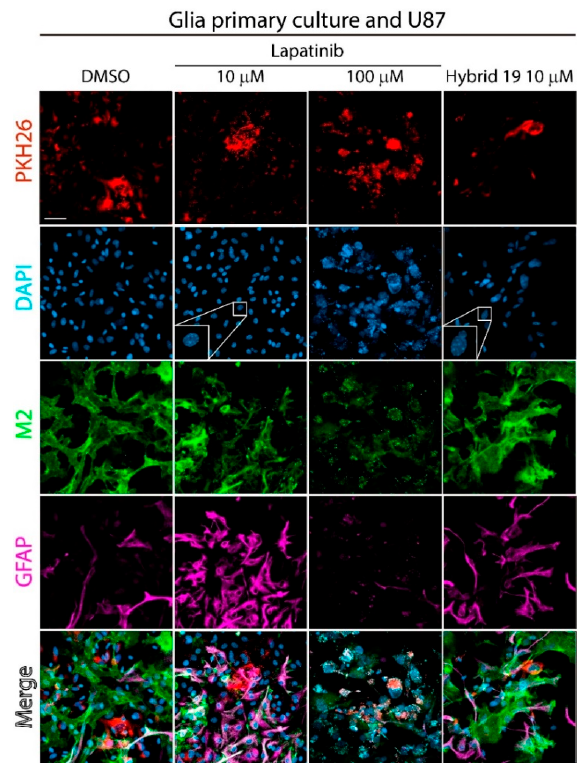
Figure 2. Effect of hybrid 19 or Lap on co-cultures of mixed glial cells with tumoral cells. Confocal images showing the co-culture of U87 MG cells (PKH26, red) with mouse neonatal cortical-derived astrocytes (M2, green and GFAP, magenta). The nuclei were stained with DAPI. Co-cultured cells were treated at IC 50,U87 MG doses of hybrid 19 or at 10 and 100 µ M for Lap and DMSO (1%) as control for 24